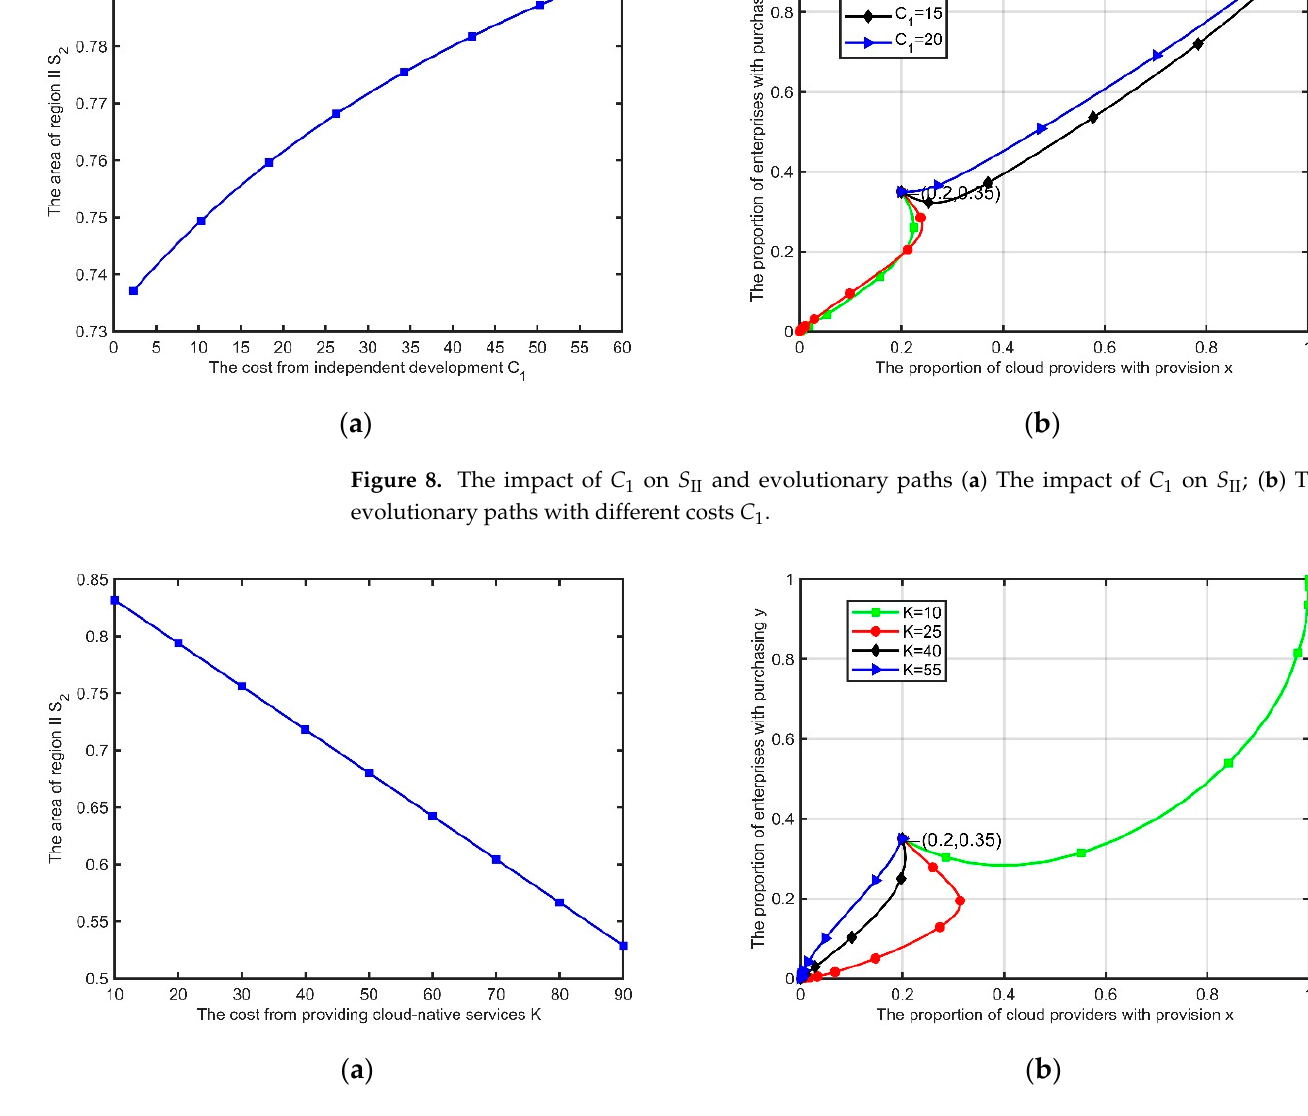
Figure 9. The impact of K on Ⅱ S and evolutionary paths (a) The impact of K on Ⅱ S ; (b) The evolutionary paths with different costs K .